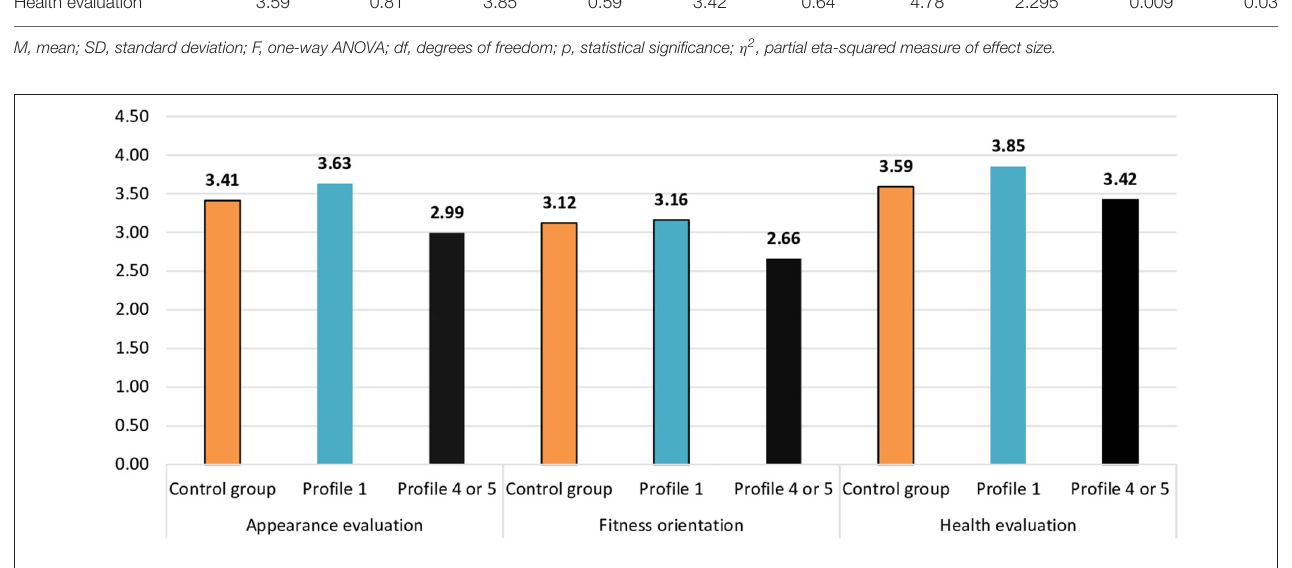
FIGURE 3 | Statistically significant relationships between profiles of perceived support and body image between pregnant women and the control